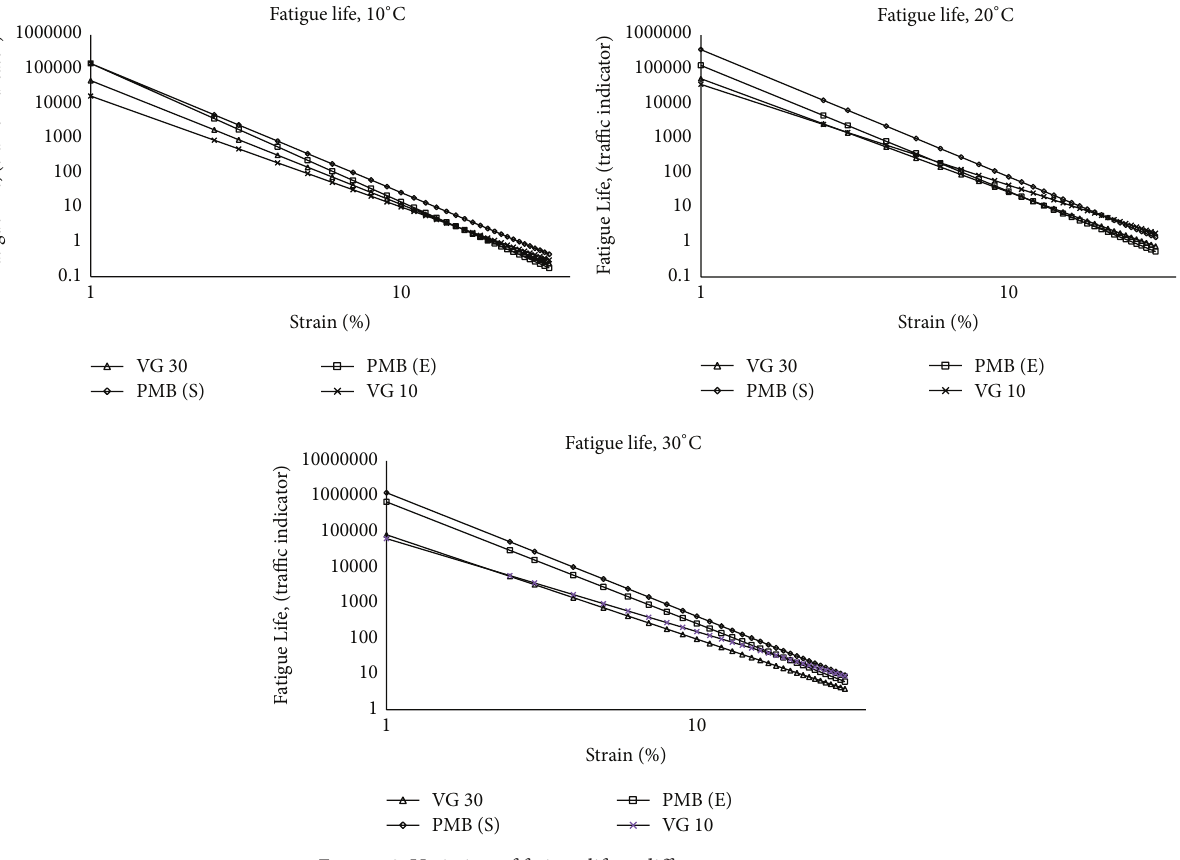
Figure 3: Variation of fatigue life at different